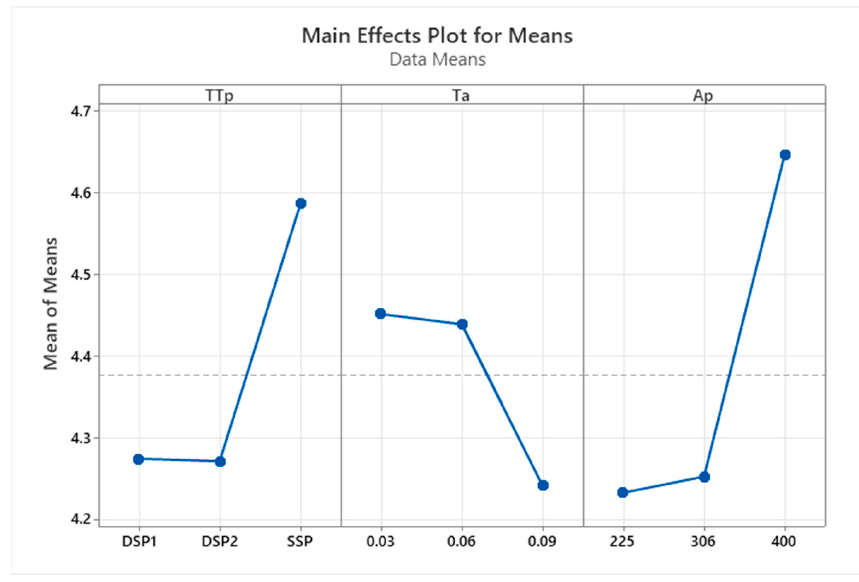
Figure 7. Main effect plot. A linear polynomial model representing the NSIF as a function of the type of composite patch, the thickness of the adhesive, and the cross-sectional area of the patch can be obtained from the ANOVA analysis and the below regression equation.